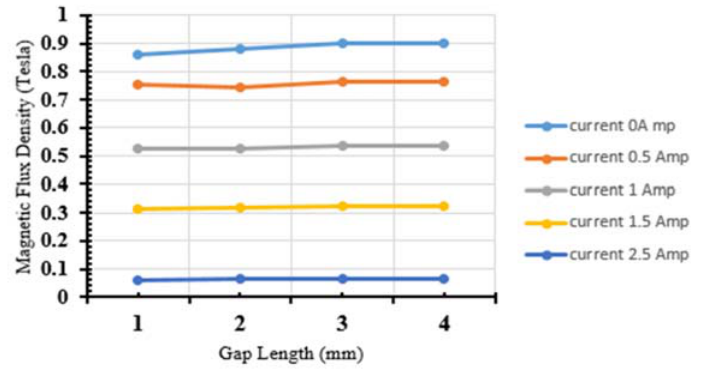
Fig. 9. The magnetic flux intensity (B) along the MR valve gap.